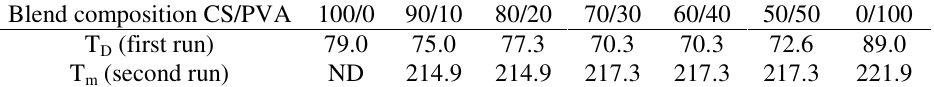
Figure 4 . The DSC second run curves of CS/PVA blended films Table 2. The thermal properties of CS/PVA blended films with different PVA content Blend composition